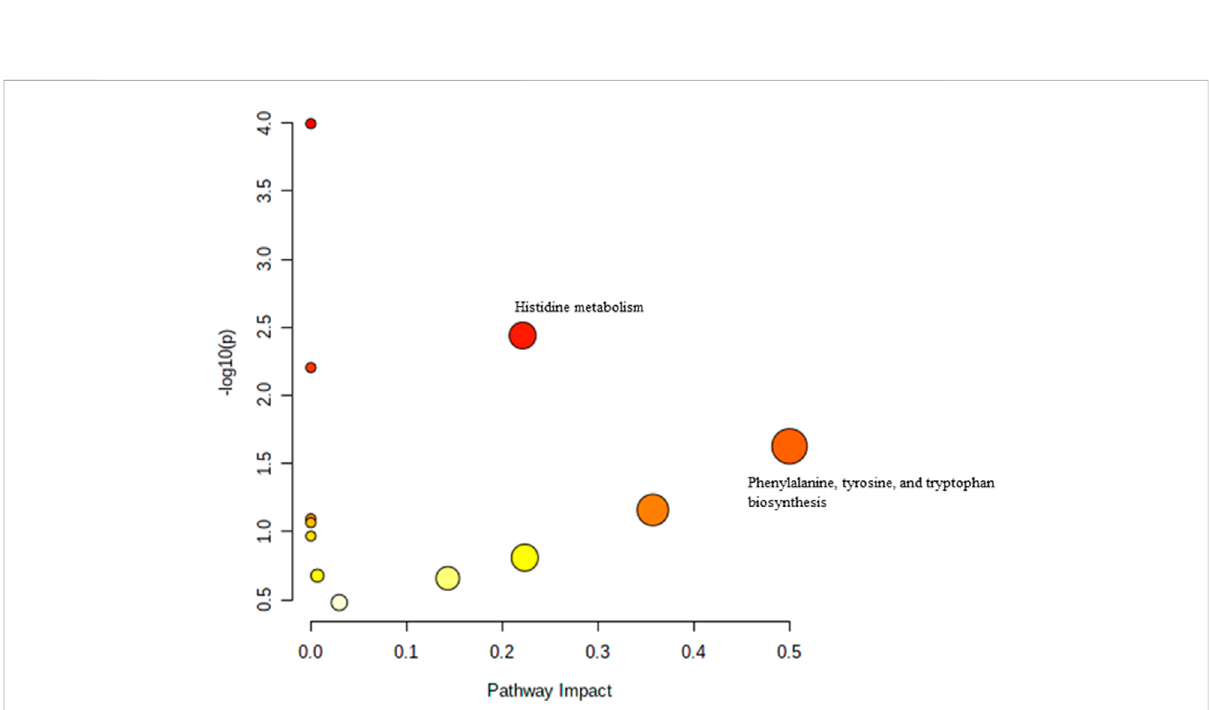
FIGURE 7 Biochemical pathway analysis of metabolites pro fi led for OC vs. OT.